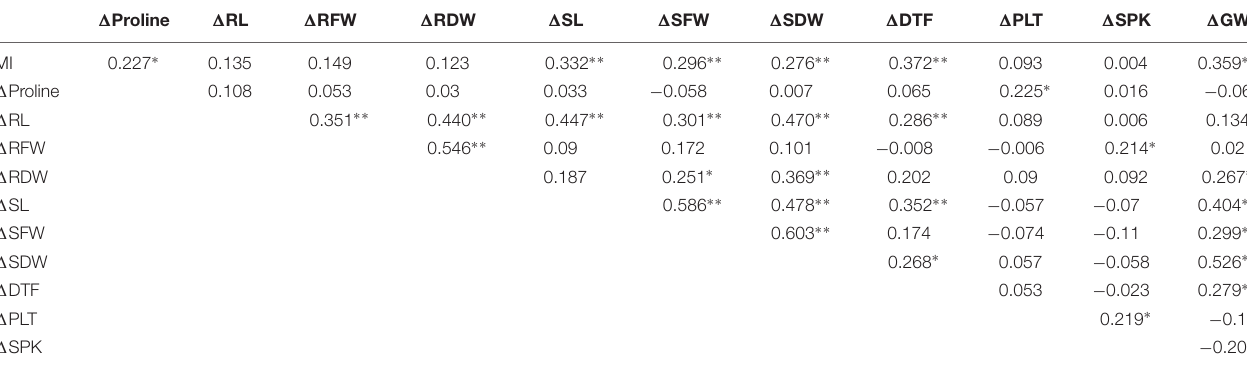
TABLE 5 | Correlations between changes in trait values used for the study of stress adaptive plasticity and BLUP values based tolerance indices under water stress